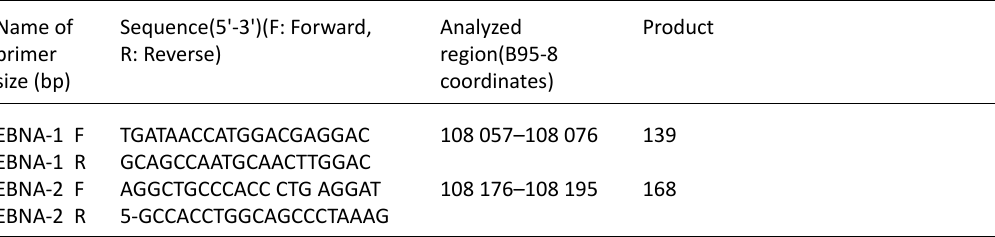
Table 1. The sequence of the primers (Synthesized by Bioneer)